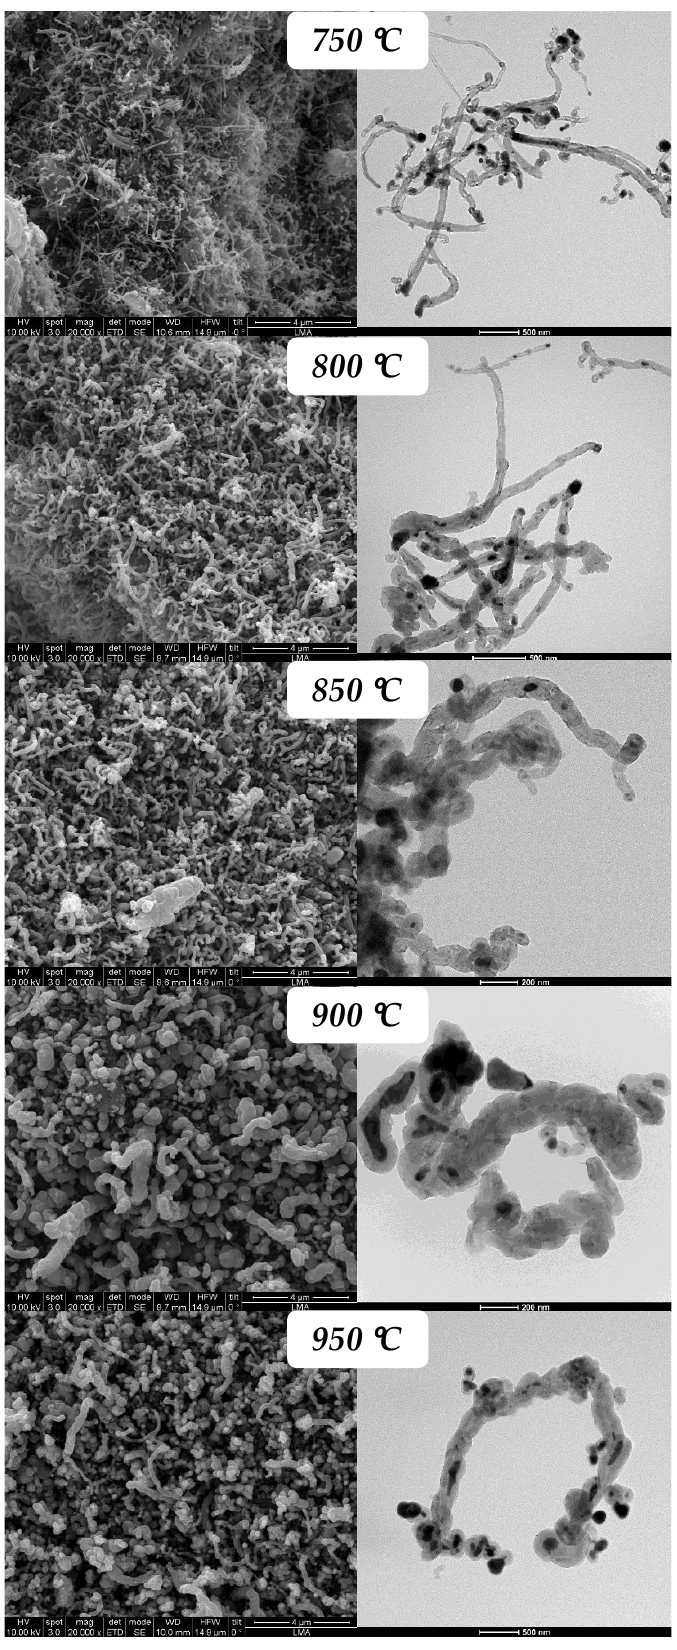
Figure 5. SEM and TEM images of the carbonaceous nanomaterials grown at different reaction temperatures for Ni – Cu/ArDC. Feed composition(%): CH 4 /H 2 /N 2 :28.6/14.3/57.1.